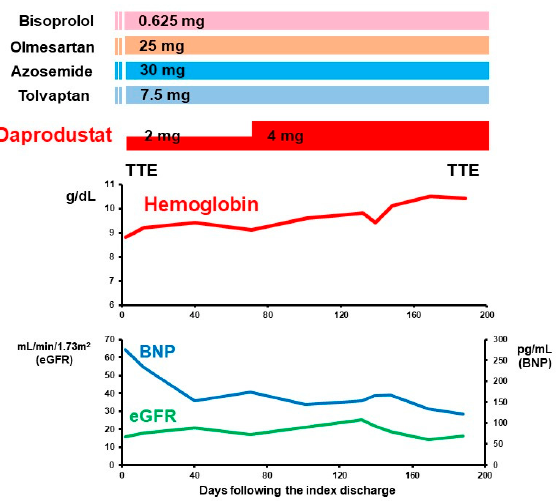
Figure 3. Six-month time course following the index discharge. TTE, transthoracic echocardiography; BNP, B-type natriuretic peptide; eGFR, estimated glomerular filtration ratio. During the 6-month follow-up period, the hemoglobin level increased gradually from around 9.0 g/dL up to 10.0 g/dL. Plasma B-type natriuretic peptide decreased from around 250 pg/mL down to 150 pg/mL. Renal function remained unchanged. At 6-month follow-up, left ventricular mass index decreased to 88 g/m 2 and cardiac output increased to 2.66 L/min (Figure 2B). Ferritin was 216 ng/mL. The degree of tricuspid regurgitation